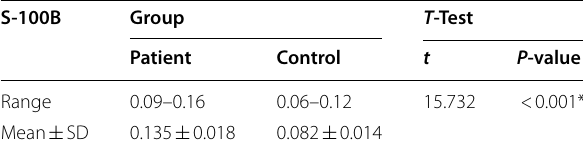
Table 2 S-100B levels in study